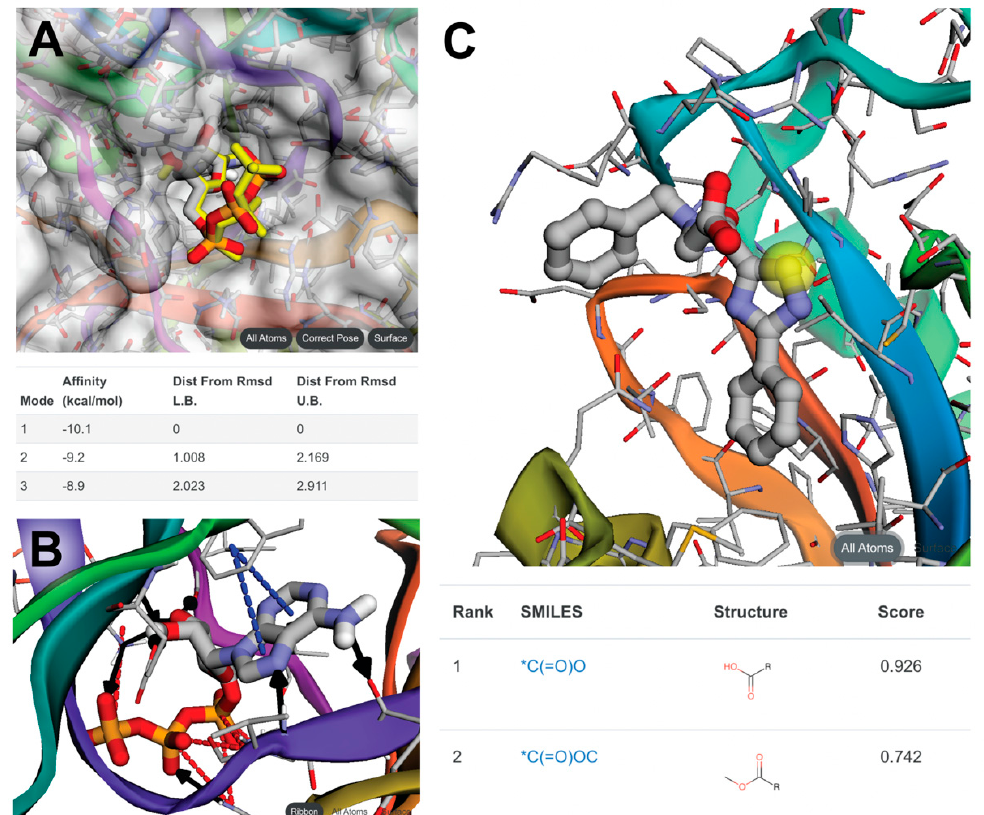
Figure 1. Three examples of browser app output. All three examples demonstrate how molecular visualization is a critical component of our in-browser approach. ( A ) Webina outputs predicted ligand poses and scores. ( B ) BINANA represents identified protein/ligand interactions as solid and dashed lines. ( C ) DeepFrag shows the protein, ligand, and ligand atom to which optimizing fragments should be added (yellow sphere). The recommended fragment additions are displayed below. Table 1. Examples of CADD browser apps created in the Durrant lab.